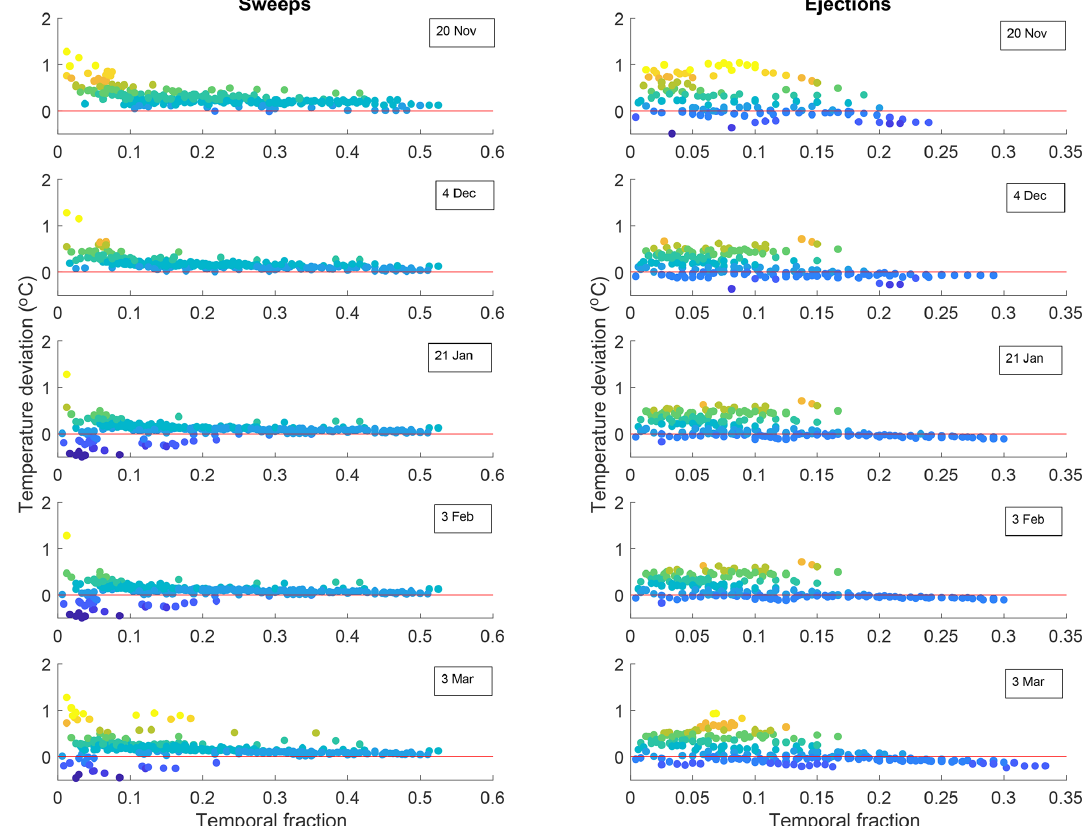
Figure 6. Fraction of time series occupied by sweep and ejection events of specific temperatures at the 20cm anemometer. Refiguring of data in Fig. 3 with same color scale. Colors here also correspond to y -axis